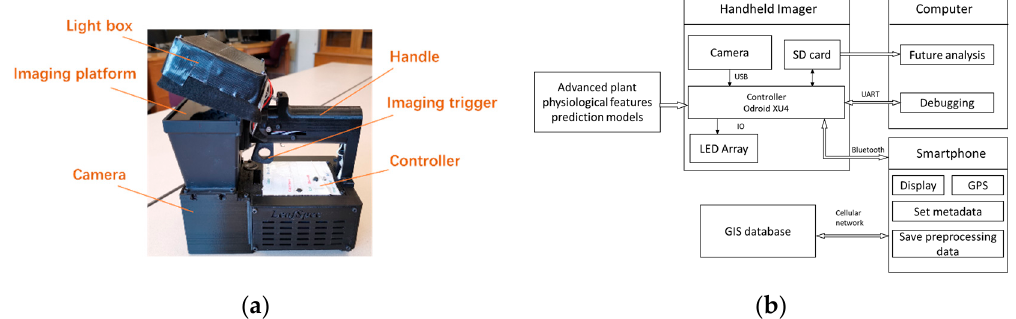
Figure 1. Handheld multispectral imager LeafScope. ( a ) Photograph of LeafScope. ( b ) The data flow and communication in LeafScope system.